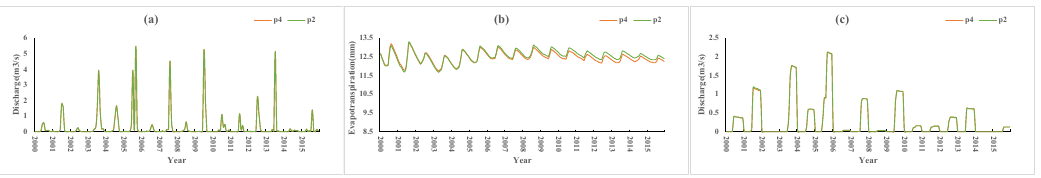
Figure 8. P3 vs. P1 simulation results: ( a ) surface runoff, ( b ) evapotranspiration, ( c ) farmland runoff.